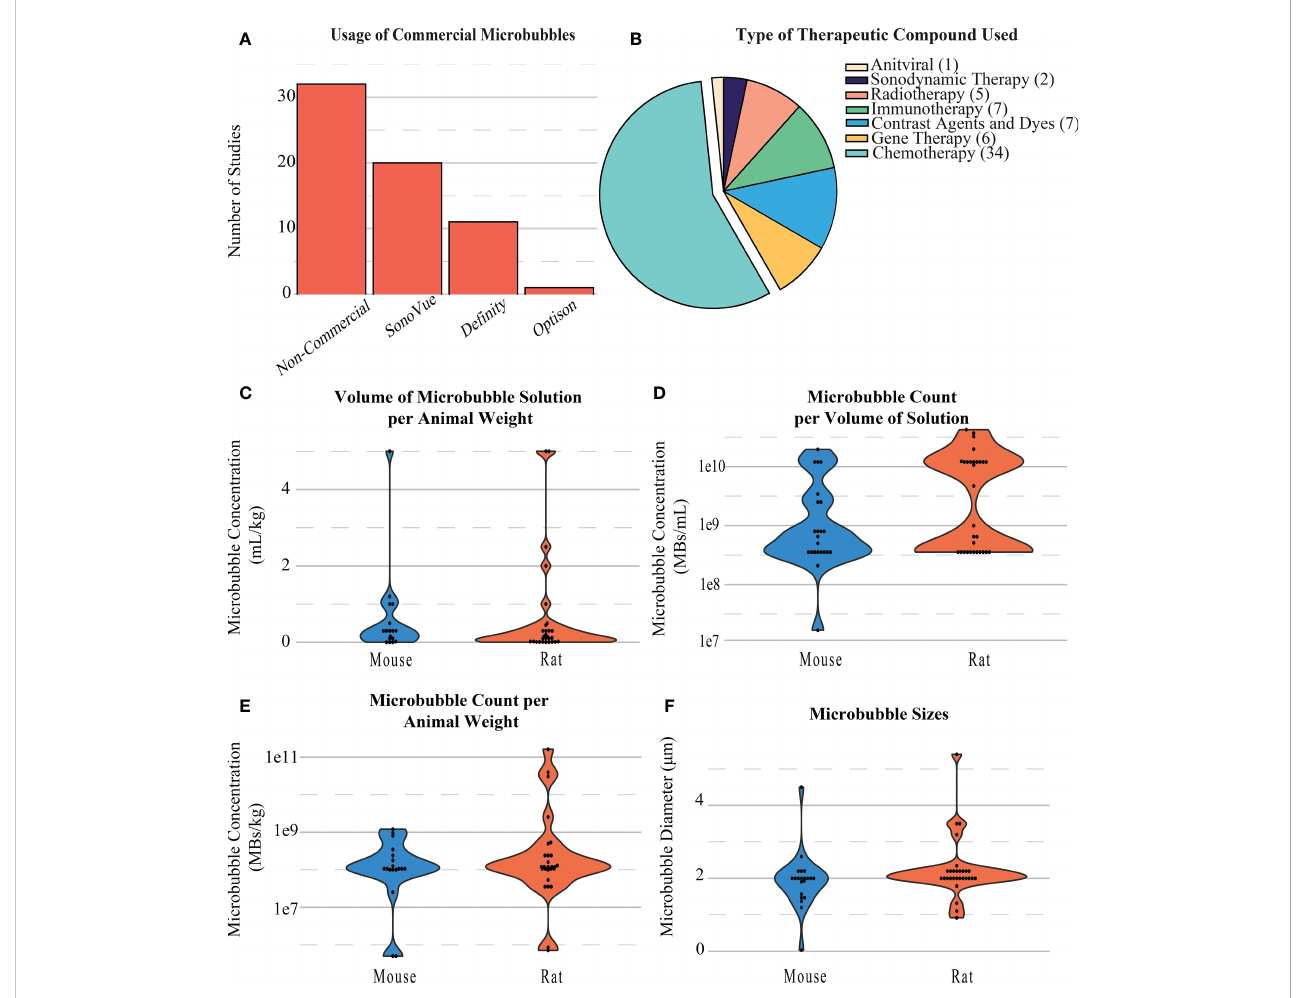
FIGURE 5 (A) Distribution of the types of microbubbles used in BBB opening studies. (B) Distribution and type of compounds delivered during BBB openings. (C) Distribution of the volumes of microbubble solution per animal weight in BBB opening studies. (D) Distribution of the microbubble count per volume of solution injected during BBB openings. (E) Distribution of the microbubble count per animal weight during BBB openings. (F) Distribution of the diameter of microbubbles during BBB